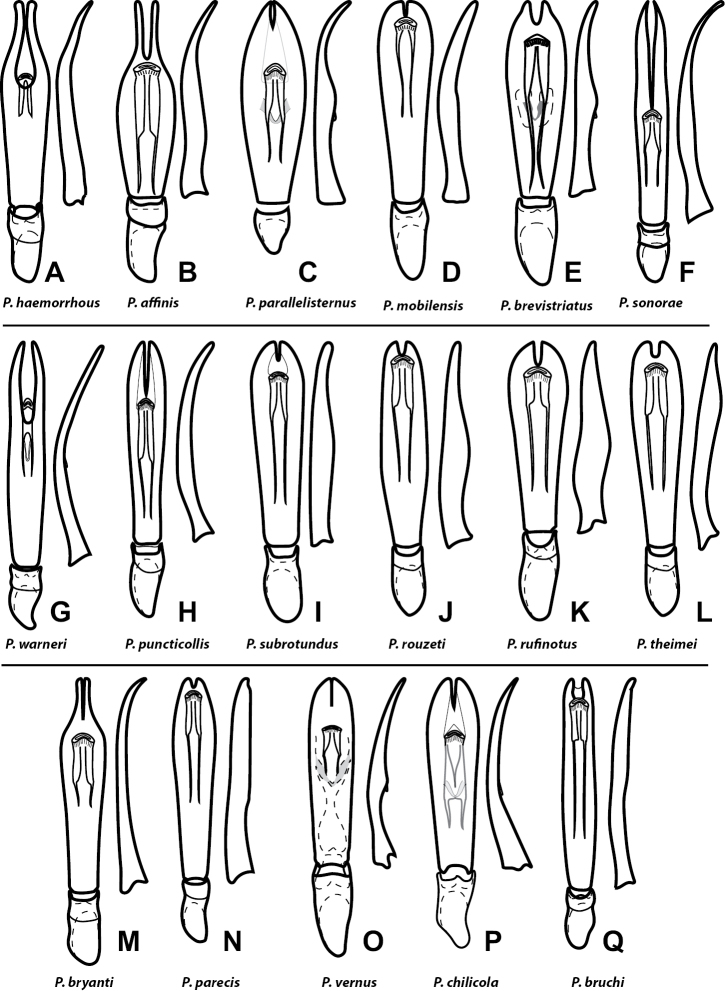
Male genitalia of all P.haemorrhous group species, dorsal and lateral views: APhelisterhaemorrhous Marseul BPhelisteraffinis JE LeConte CPhelisterparallelisternus Schmidt DPhelistermobilensis Casey EPhelisterbrevistriatus Casey FPhelistersonorae sp. nov. GPhelisterwarneri sp. nov. HPhelisterpuncticollis Hinton IPhelistersubrotundus (Say) JPhelisterrouzeti (Fairmaire) KPhelisterrufinotus Marseul LPhelisterthiemei Schmidt MPhelisterbryanti sp. nov. NPhelisterparecis sp. nov. OPhelistervernus (Say) PPhelisterchilicolaQPhelisterbruchi Bickhardt.